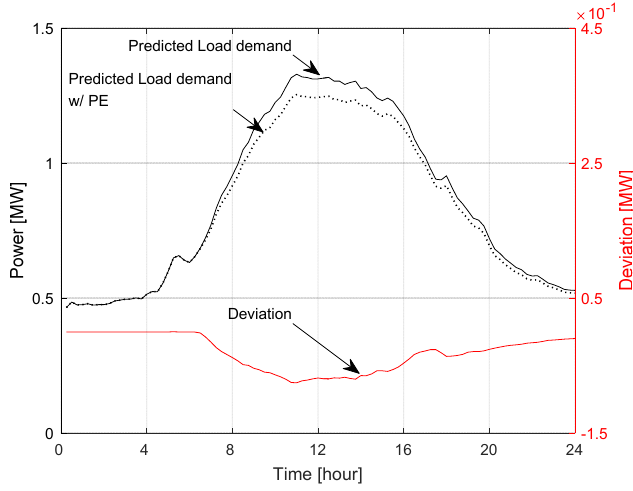
Figure 4. Predicted load demand for two simulation cases.